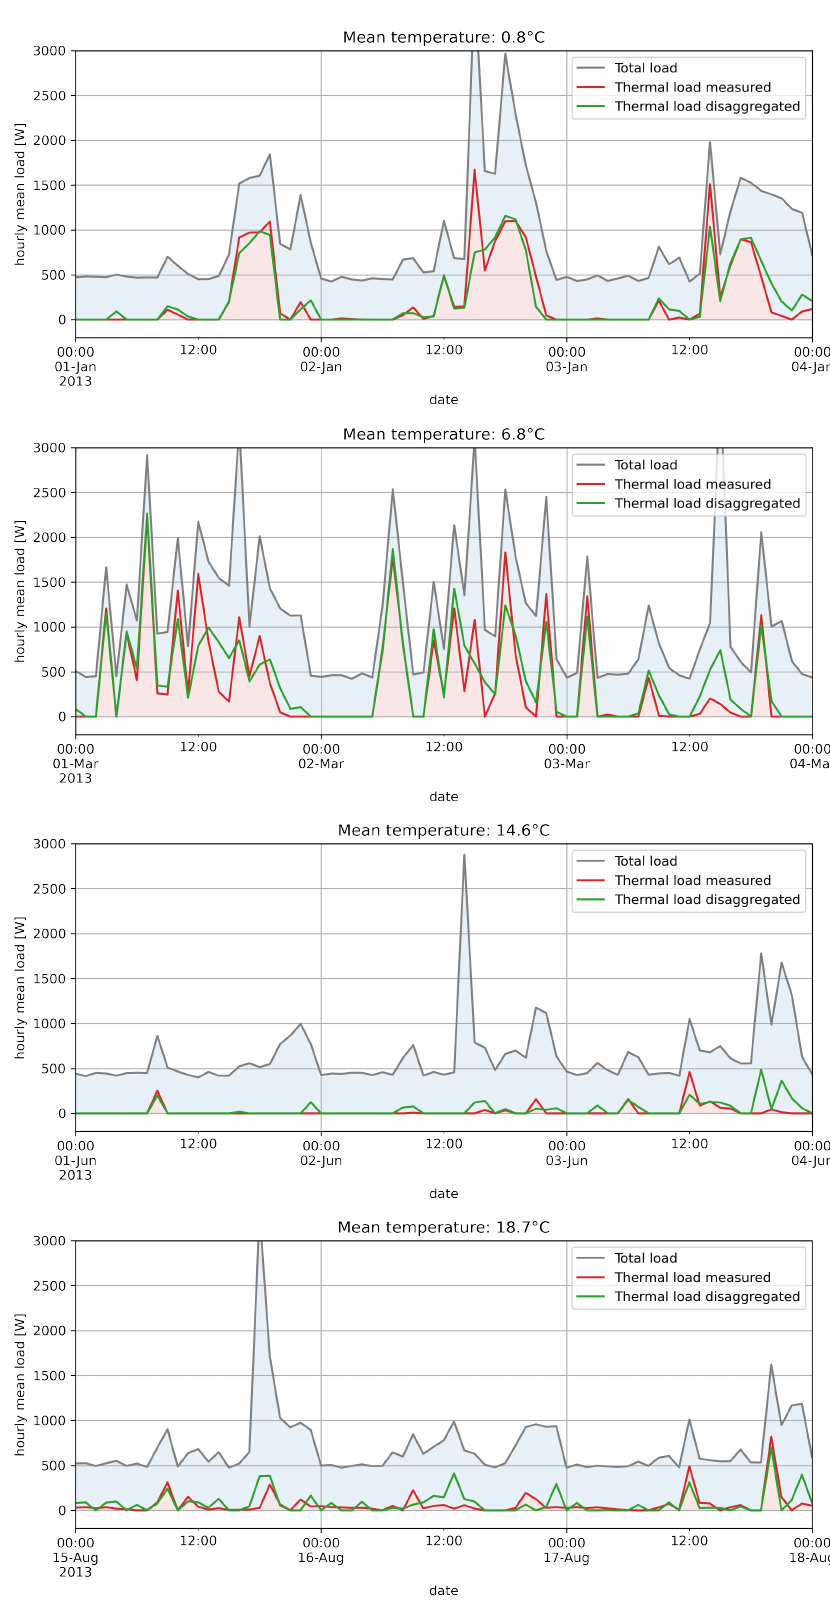
Figure 5. Load disaggregation examples for different periods in a year, with different values of the outdoor mean